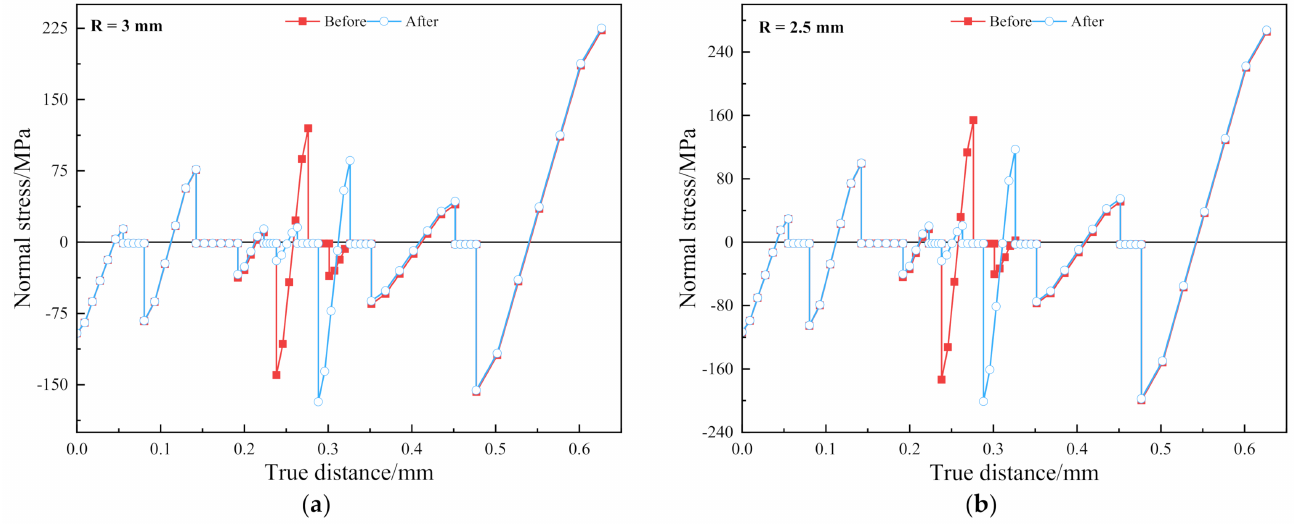
Figure 5. ( a ) Contrast curve of normal bending stress along the central axis before and after the interchange of the OLED and BP layers under R = 3 mm; ( b ) contrast curve of normal bending stress along the central axis before and after the interchange at R = 2.5 mm.